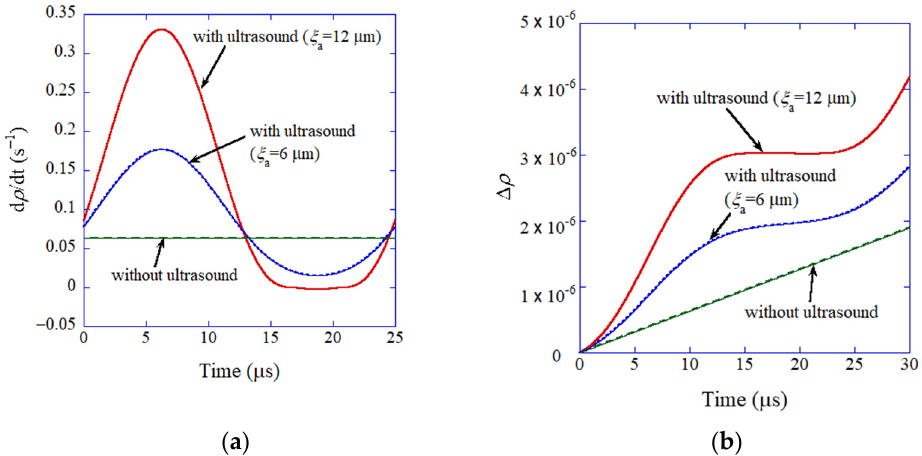
Figure 12. The results of numerical simulations of the ODE model for ultrasound-assisted sintering of silver nanoparticles as a function of time ( a ) The densification rate. ( b ) The change in the relative density. Reprinted with permission from Ref. [88]. Copyright 2021, AIP Publishing.